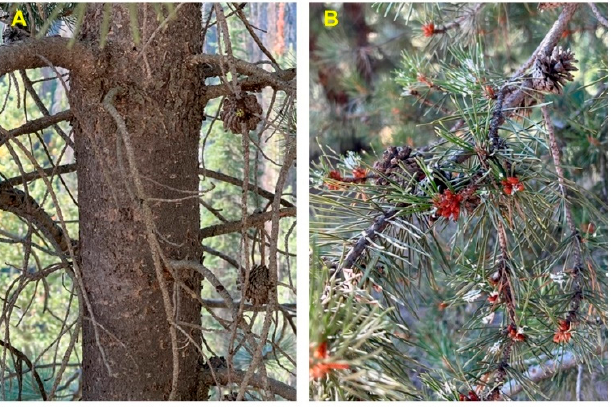
Figure 6. Pinus contorta subsp. latifolia from southern Idaho. ( A ): bark. ( B ): leaves and cones. Photographs by K. Swor.